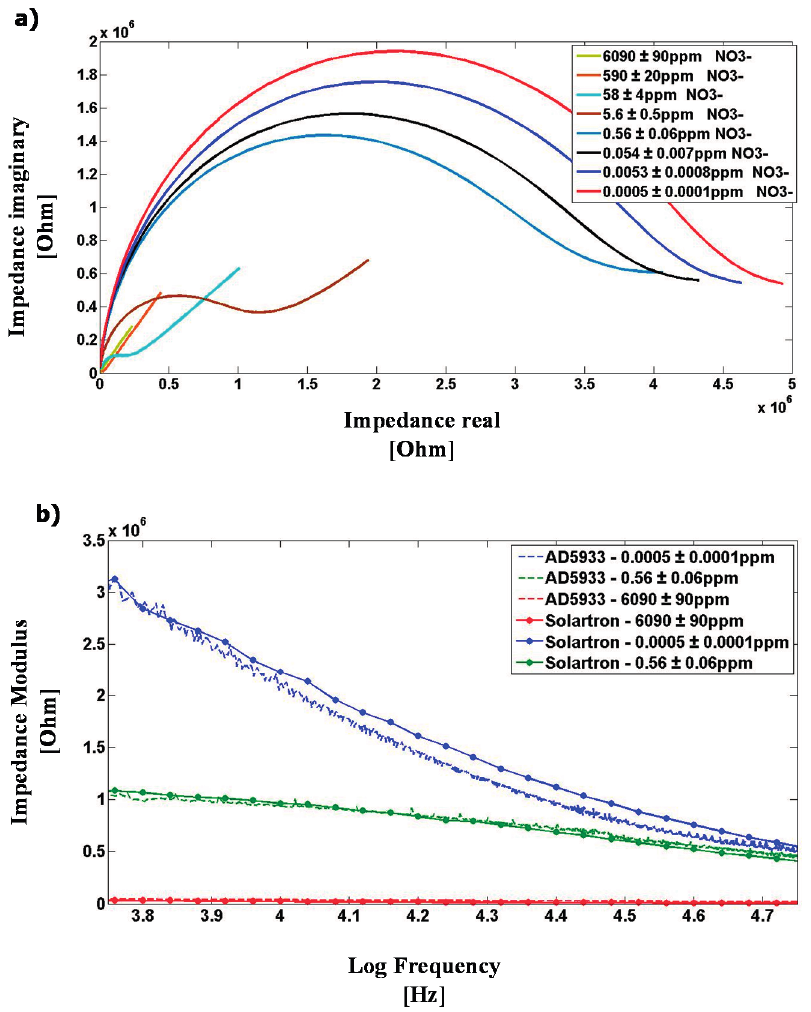
Figure 6. ( a ) Nyquist response of the EIS nitrate sensor as measured by the Solartron